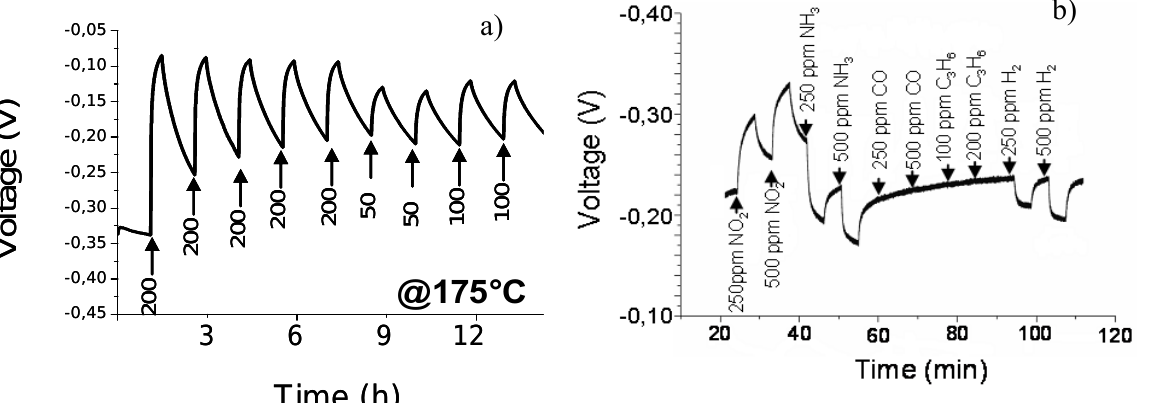
Figure 7. Calibration curve of a Au-NP sensor exposed to NO (panel b ) and responses of the same sensor to NO both cases the working temperature is 175 °C. Reprinted with permission from reference